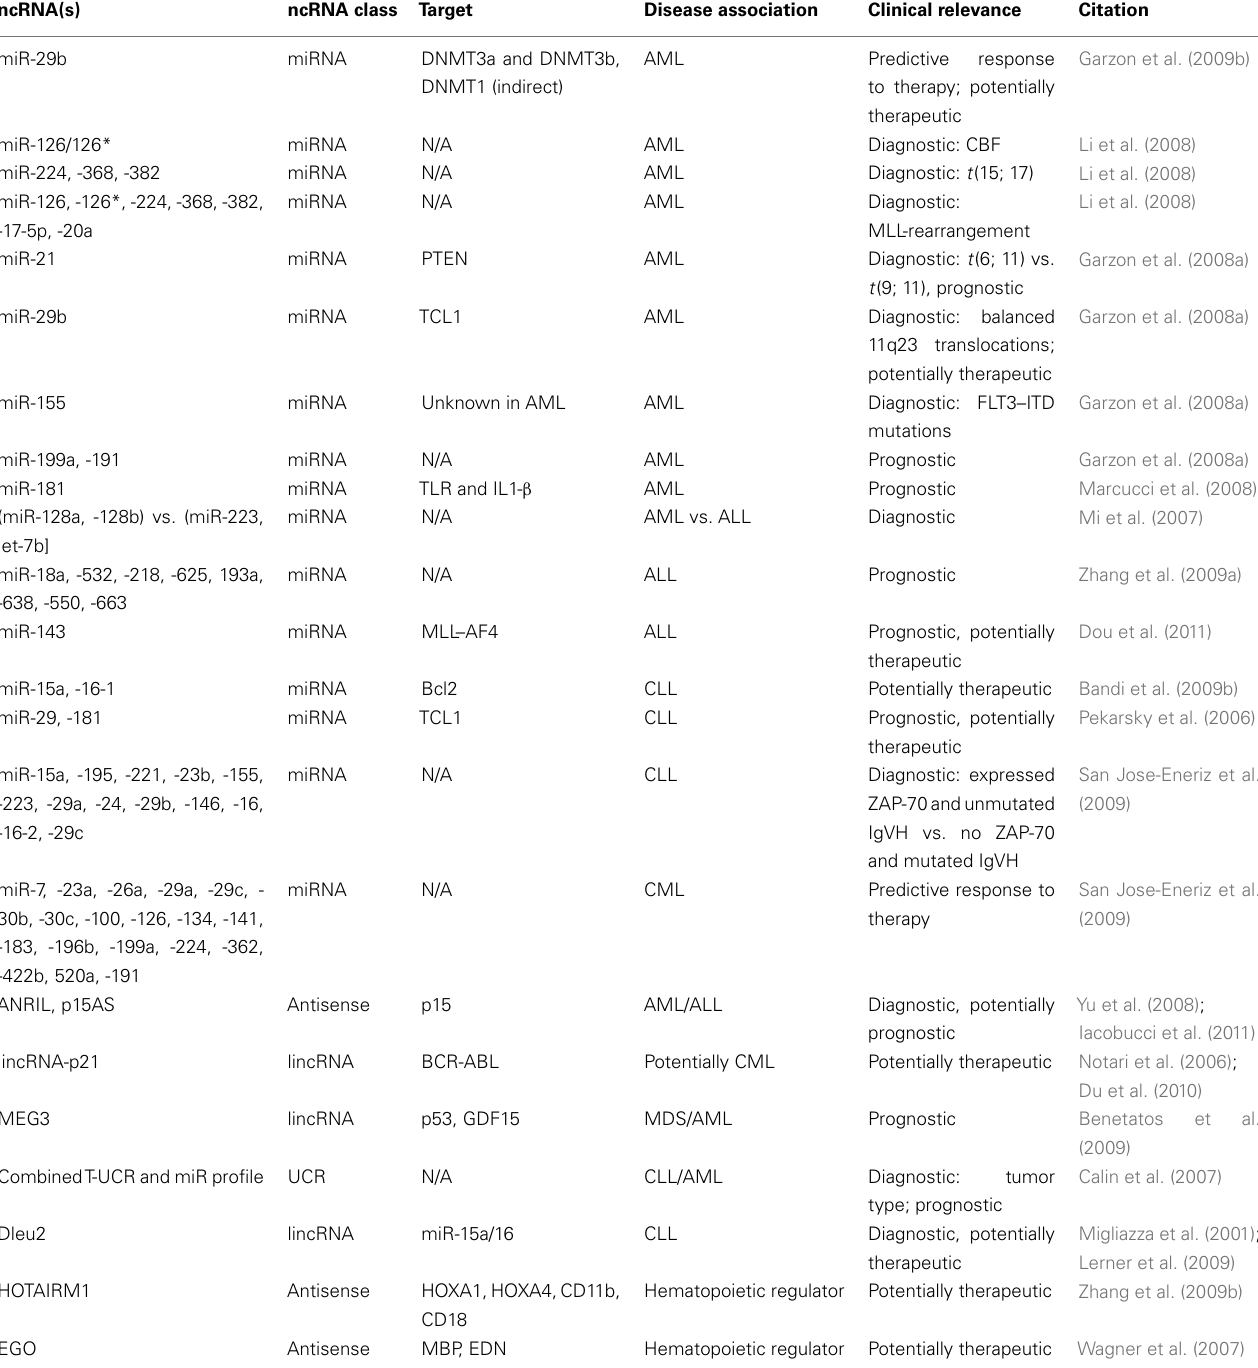
Table 1 | Characteristics of discussed ncRNAs a